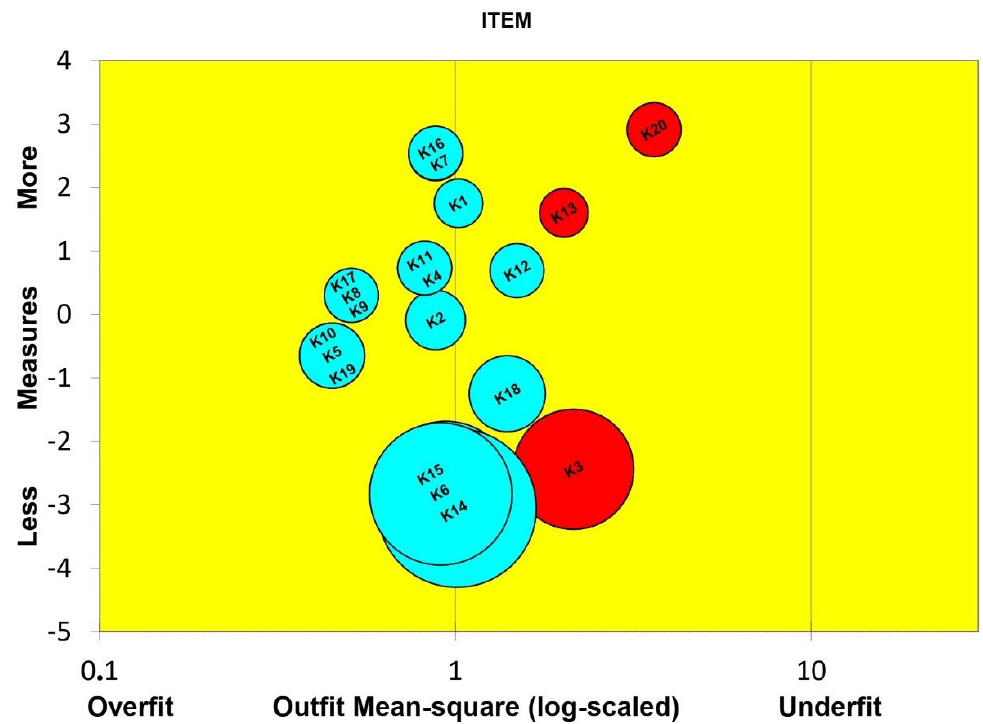
Figure 1. Bubble chart of item fit order based on Infit MNSQ; Y axis is JMLE measure; X axis is item fit mean square; overfit (x >1.50); outfit (0.50 < x < 1.50). Each bubble represents an item whose size is proportional to the standard error of item difficulty calibration. Well-fitting items are close to the central vertical line.